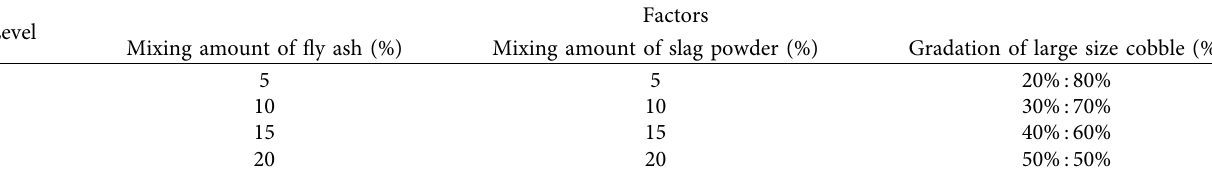
Table 1: Orthogonal levels of different factors.